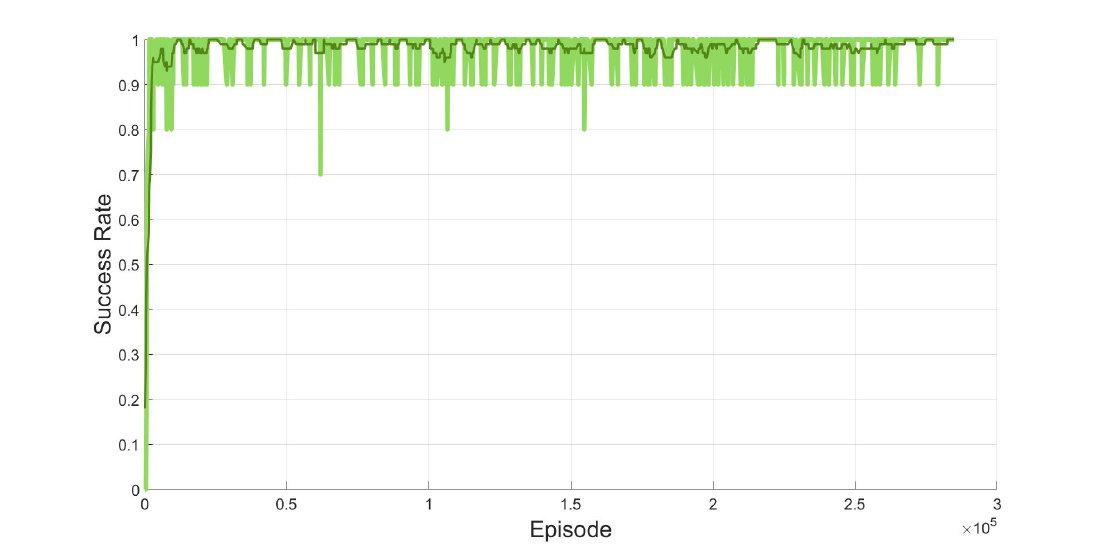
Figure 6. Success ratio by the proposed SAC-based path planning for two open